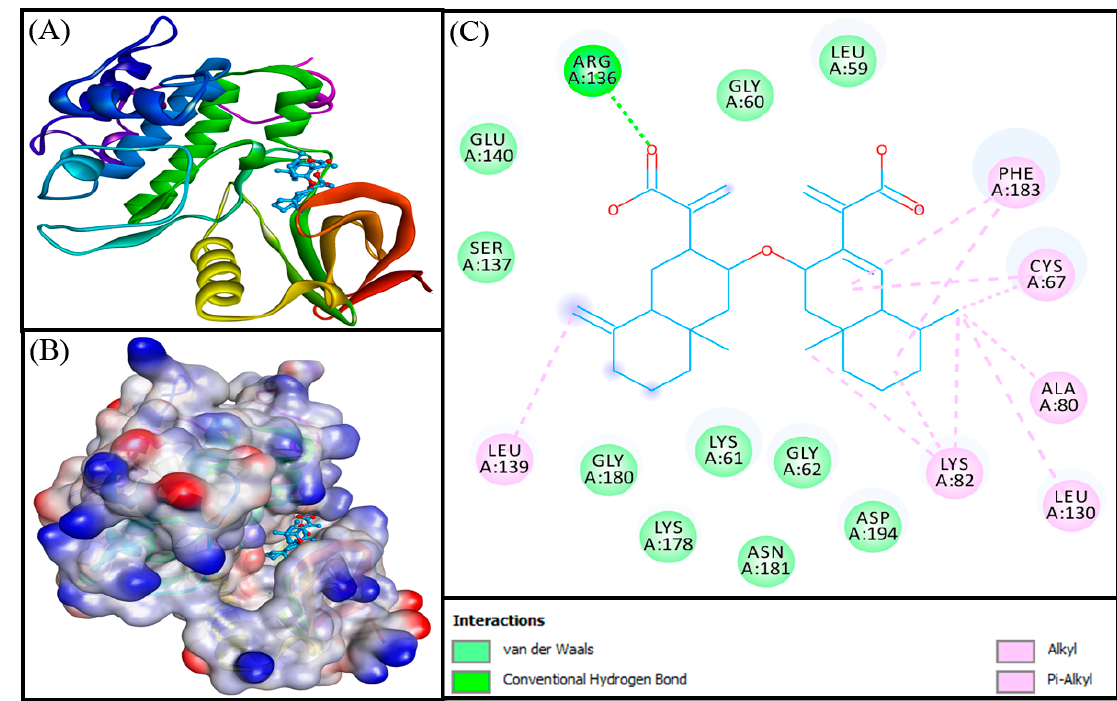
Figure 3. Molecular docking of compound 1 to the catalytic domain of Polo-like kinase 1 (PLK-1). ( A ) 2D representation of the binding of compound 1 at the ATP binding site of PLK-1, ( B ) binding of compound-1 at the ATP binding cavity of PLK-1, ( C ) molecular interaction between PLK-1 and compound 1 .